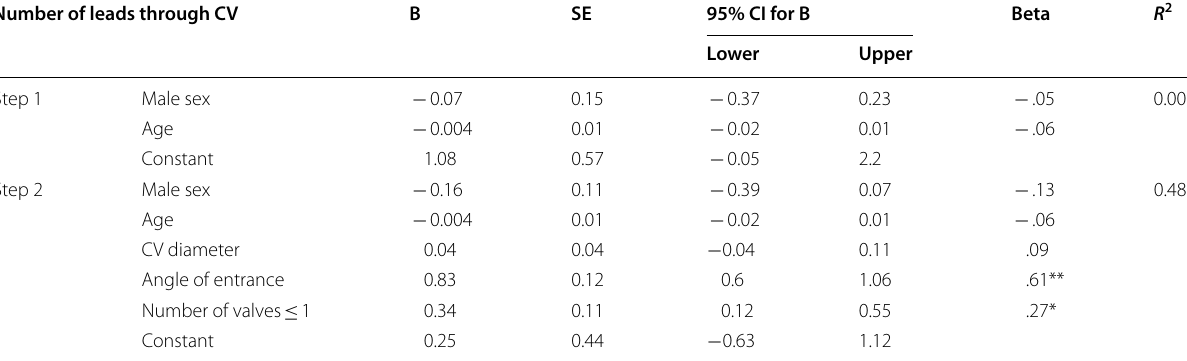
R 2 .006 for Step 1; Δ R 2 =